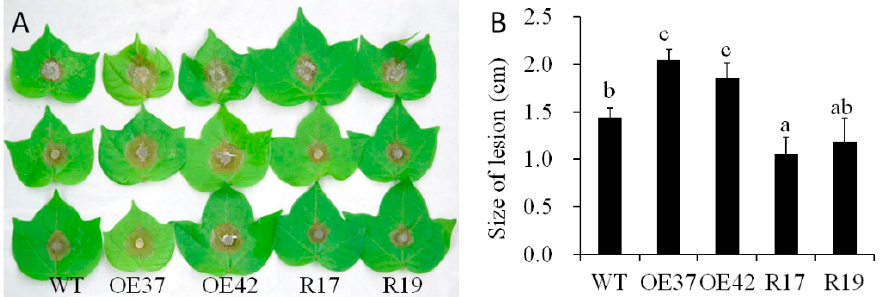
Figure 4. GhHB12 negatively regulates the resistance to B. cinerea in cotton. ( A ) Phenotypes of GhHB12 transgenic lines (overexpression lines: OE37 and OE42; RNAi lines: R17 and R19) and wild-type (WT) cotton leaves after inoculation with B. cinerea for three days. ( B ) The size of the lesions on the leaves indicated in ( A ). Error bars indicate the standard deviation of 7–22 lesions, and different letters indicate significant differences at p < 0.05 (Duncan’s multiple range test).